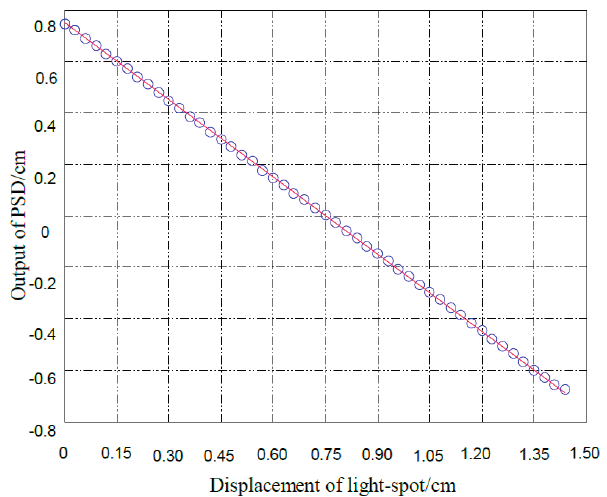
Figure 5. The calibration curve of the